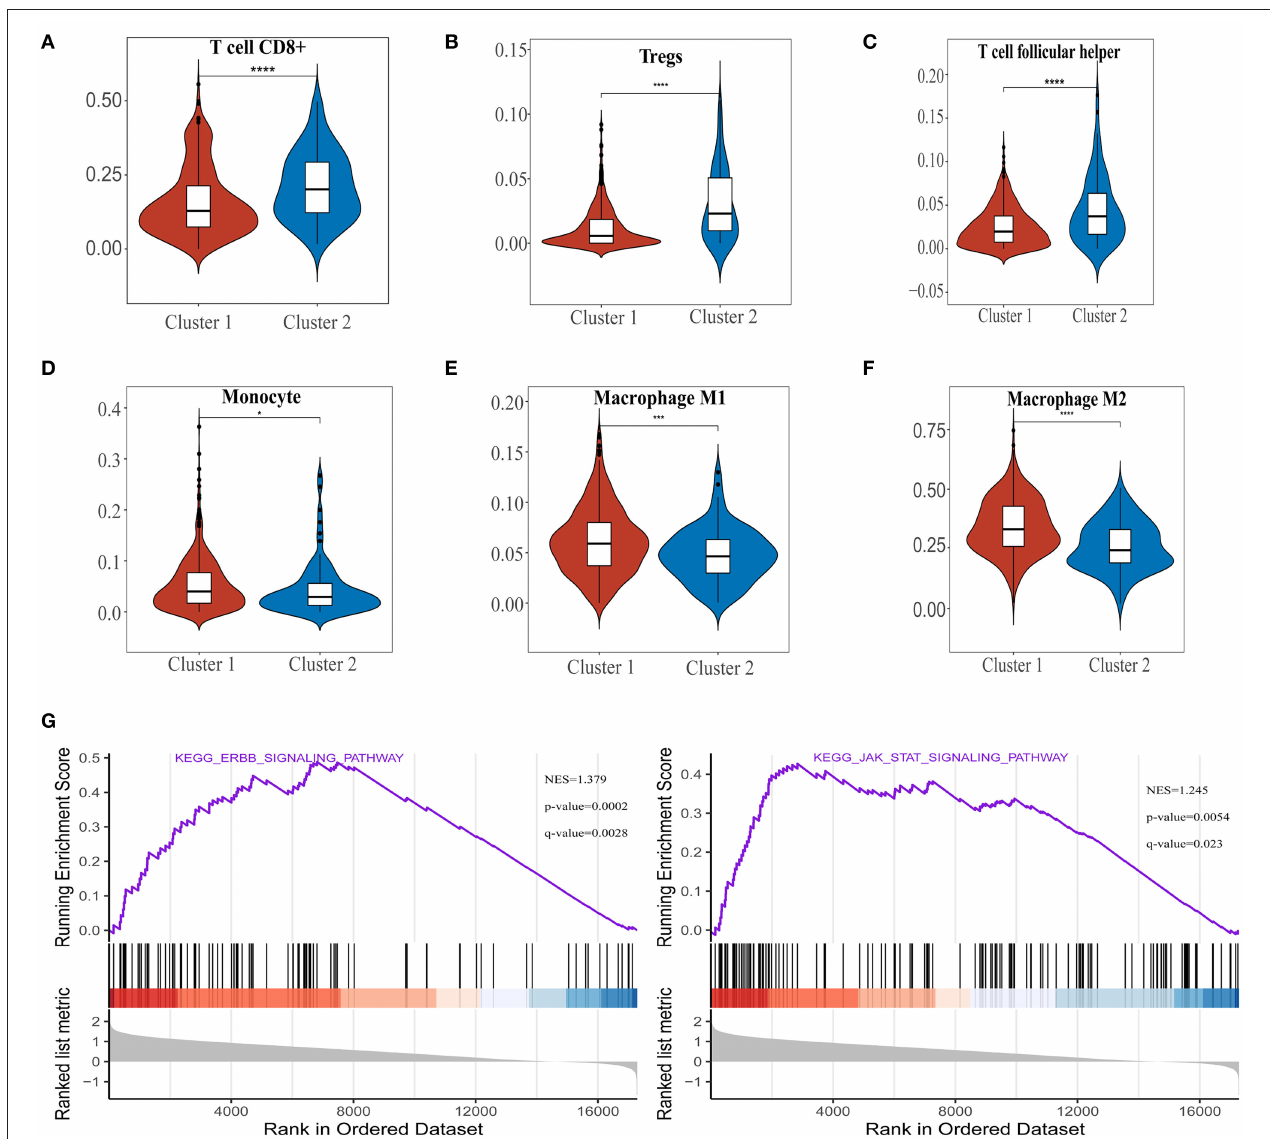
FIGURE 4 | The differences of immune cell infiltration levels in two clear cell renal cell carcinoma (ccRCC) subtypes. (A–F) The infiltration level of the CD8 + T cell (A) , Tregs (B) , and T follicular helper cell (C) were downregulated in cluster 1 ccRCC patients. The infiltration levels of the monocyte (D) , M1 macrophage cell (E) , and M2 macrophage cell (F) were upregulated in cluster 1 ccRCC patients. (G) Gene set enrichment analysis indicated that ERBB signaling and the JAK-STAT signaling pathways are significantly enriched in cluster 1. NES, normalized enrichment score; q -value, false discovery rate. * p < 0.05, *** p < 0.001, and **** p <